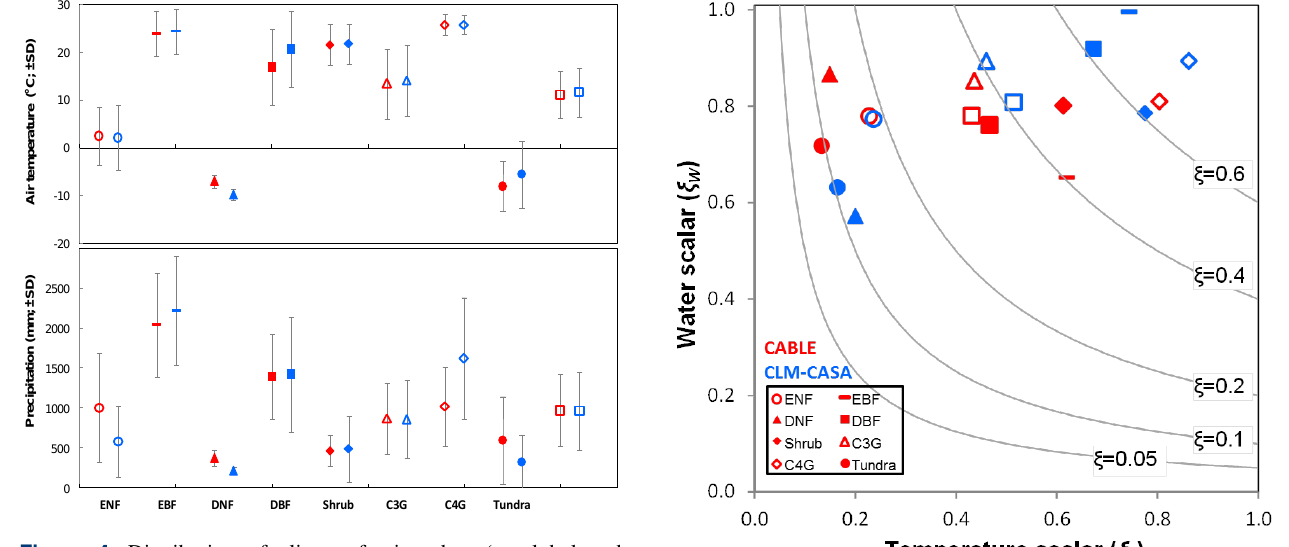
Figure 4. Distribution of climate forcing data (at global and biome levels) used for CABLE and CLM-CASA (cid:48) simulations. Open square show the global values. Abbreviations of biomes are given in Fig. 1.